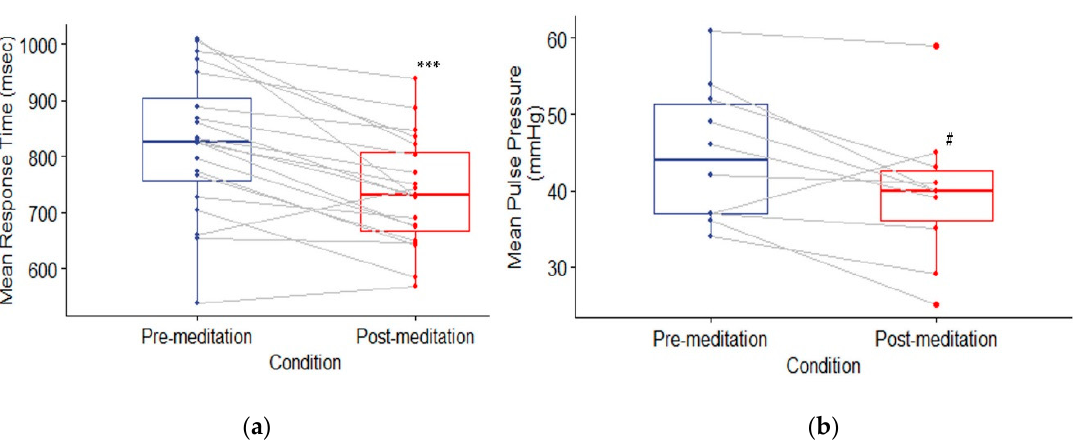
Figure 3. Comparisons of Pre-meditation (blue) to Post-meditation (red) conditions for ( a ) behavioral and ( b ) physiological outcomes. Mean response time (RT) in ms is the behavioral outcome ( n = 20), while the mean pulse pressure (PP) in millimeters of mercury (mmHg) is the physiological outcome ( n = 10). Grey lines represent each subject’s pre-meditation and post-meditation responses. *** ( p FDR < 0.001), # ( p FDR = 0.07).